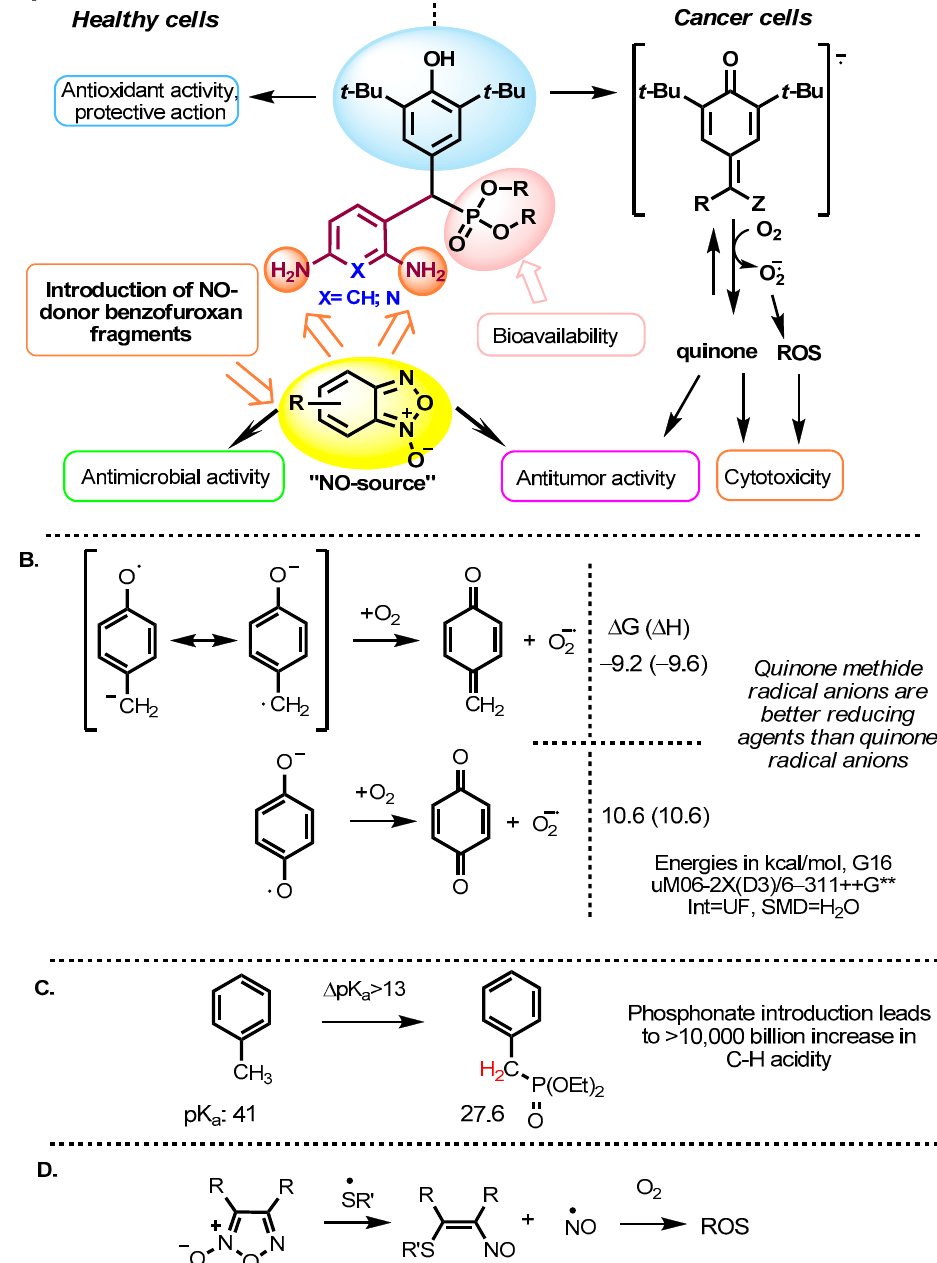
Figure 1. ( A ) General approach to the creation of new types of hybrid antitumor agents based on sterically hindered phenols (SHP) and benzofuroxans. ( B ) Redox cycling between phenols and quinone methides creates radical anions that can reduce molecular oxygen to a superoxide anion. ( C ) Phosphonate group greatly activates benzylic C-H bonds and facilitates quinone methide radical-anion formation. ( D ) Generation of NO and ROS from furoxans. ROS = Reactive Oxygen Species.